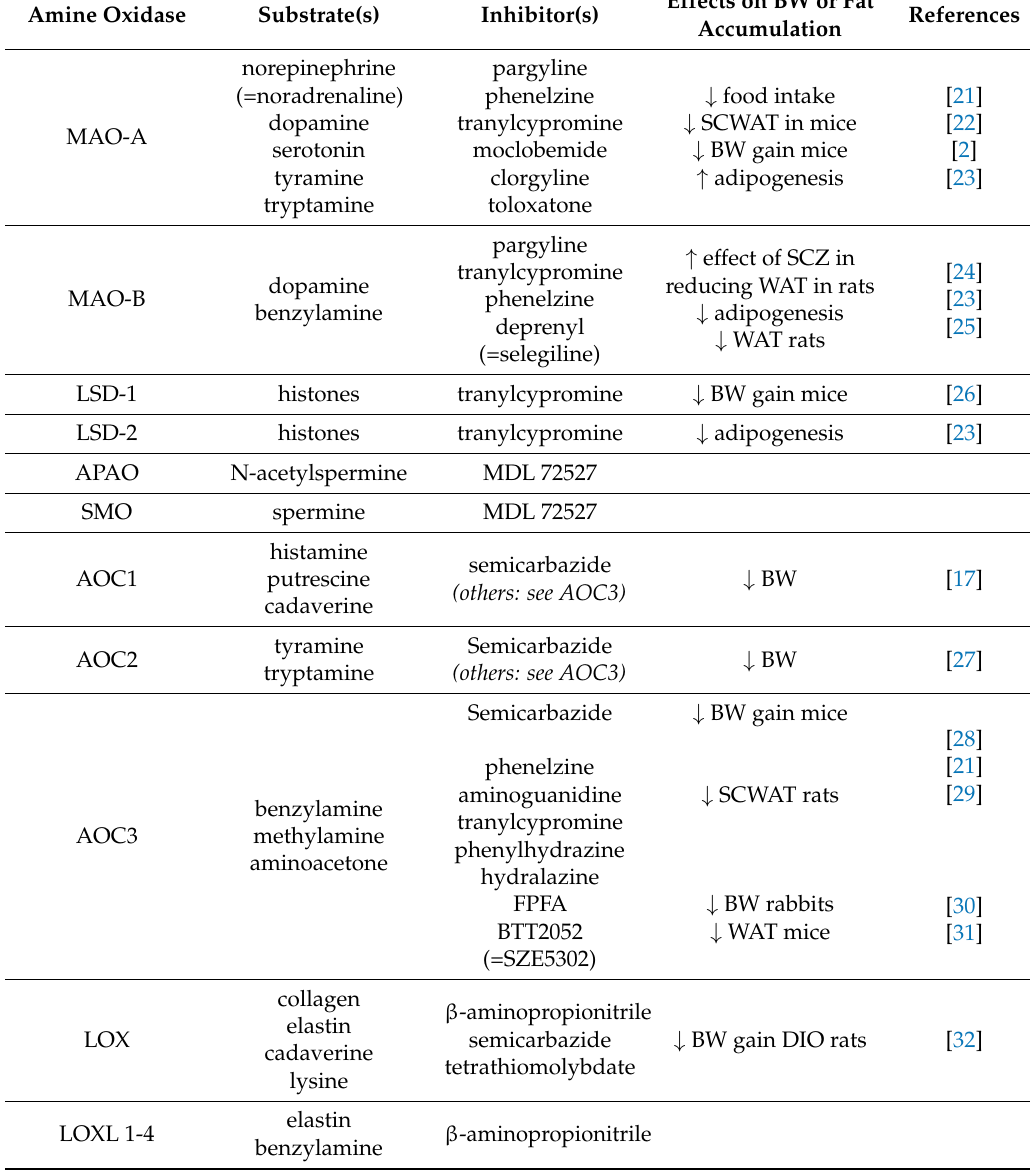
Table 1. Mammalian amine oxidases, their substrates and the effects of their inhibitors on body weight control or in vitro